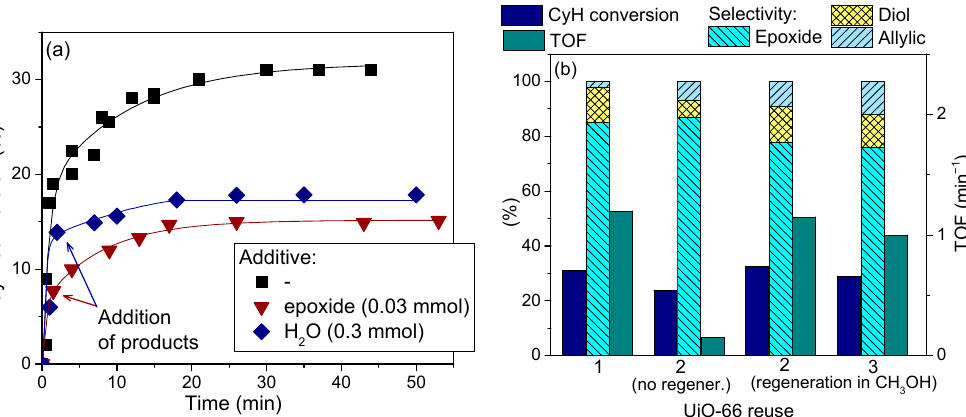
Figure 10. ( a ) Effect of reaction products on CyH oxidation over UiO-66 and ( b ) recycling of UiO-66. Reaction conditions: CyH 0.1 mmol, H 2 O 2 0.1 mmol, 2 mg UiO-66 (7 μ mol Zr), HClO 4 7 μ mol, CH 3 CN 1 mL, 50 o C.